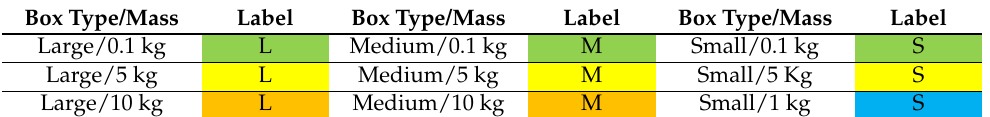
Table 2. Types and masses for the